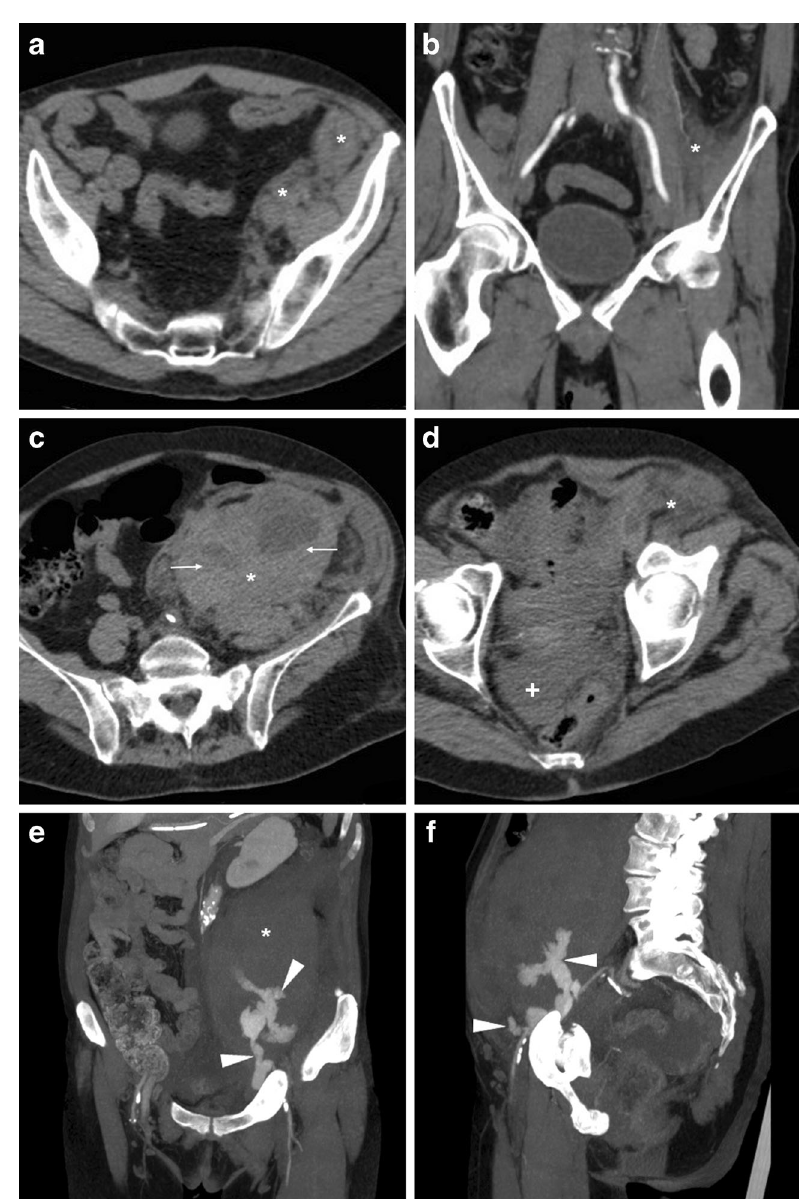
Fig. 4 Intra-abdominal haemorrhages. A-B) In a 66-year- old man with severe peripheral artery disease (PA), shortly after percutaneous transluminal angio- plasty (PTA) and stenting of the left femoral artery with ipsilateral vascular access, precontrast (A) CT images showed high- attenuation subperitoneal effusion (*) along the left iliac muscle, without active bleeding at CT- angiography (B), which was treated conservatively. C-F) In a 75-year-old woman with obliter- ating PAD, following PTA and stenting of the right superficial femoral artery via left CFA ac- cess, precontrast images (C, D) showed extensive, mass-like left retroperitoneal haematoma (*) with characteristic fluid-fluid levels (thin arrows), mild haemoperitoneum (+) in the pel- vic cul-de-sac. CT angiography with maximum-intensity projec- tion (MIP) images (E, F) showed extraluminal CM flowing from the site of arterial injury, indica- tive of active bleeding. Note displaced ipsilateral